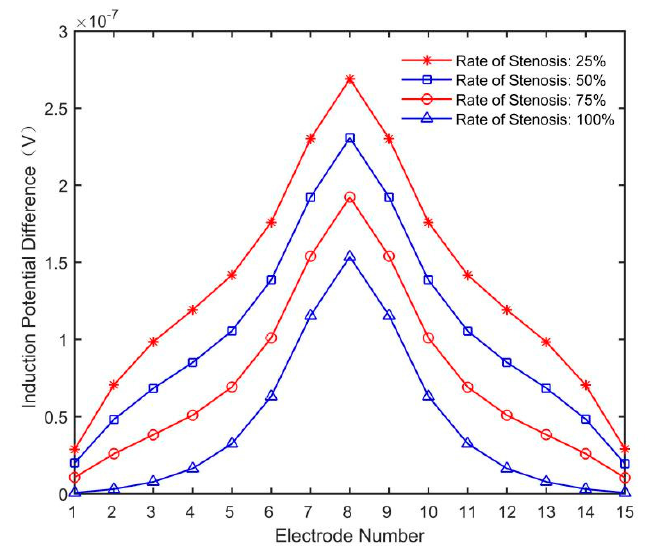
Figure 12. Induction potential difference distribution at different rates of stenosis.